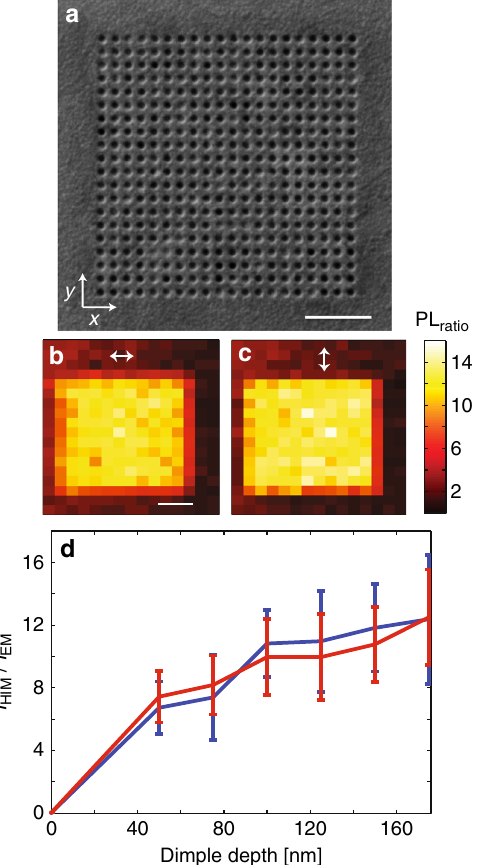
Fig. 4 Polarization-independent photoluminescence enhancement achieved with a high-impedance metasurface featuring an array of